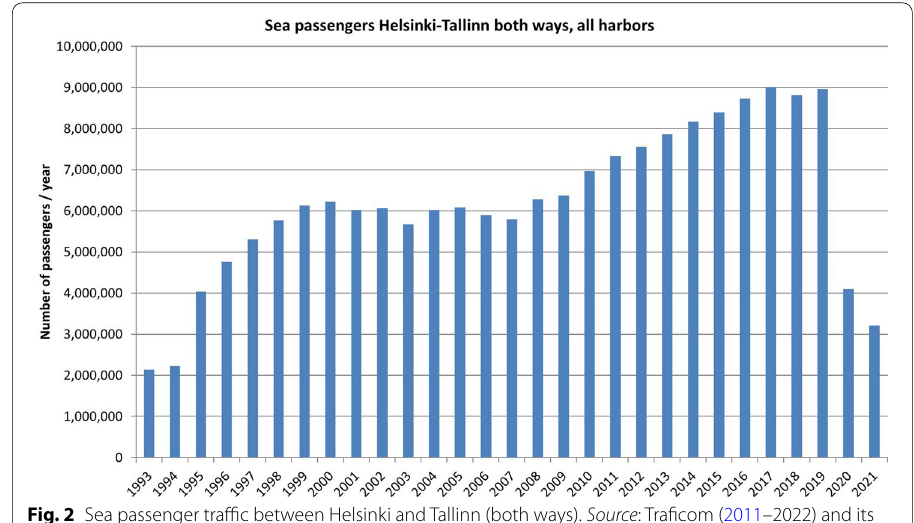
Fig. 2 Sea passenger traffic between Helsinki and Tallinn (both ways). Source : Traficom (2011–2022) and its predecessors—author’s own